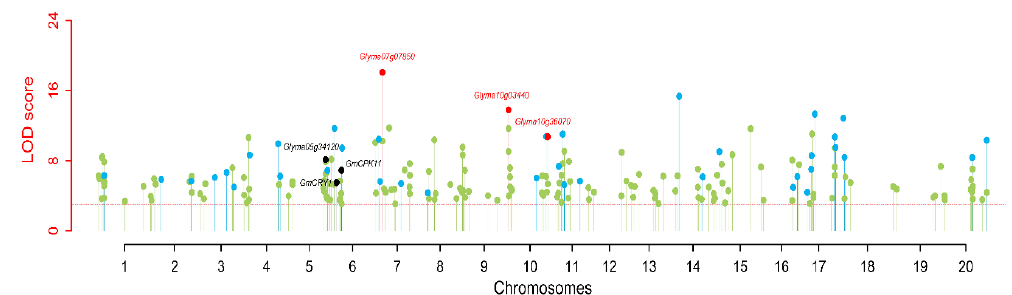
Figure 3. Stable QTNs of soybean 100-seed weight identified in four environments and BLUP values by using six ML-GWAS methods. The black color dots were the stable QTNs near previously reported genes ( Glyma05g34120 , GmCRY1 , and GmCPK11 ), while the red color dots were the stable QTNs near predicted candidate genes in this study. The sky blue color dots were other stable QTNs, while the light green color dots were remaining significant QTNs.